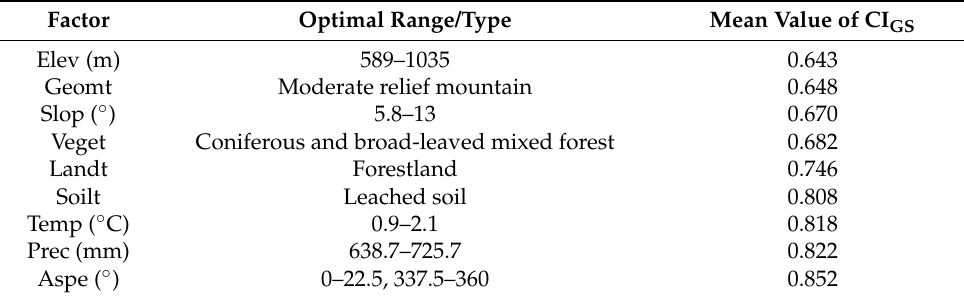
Table 6. The optimal range/type for clumping effects of